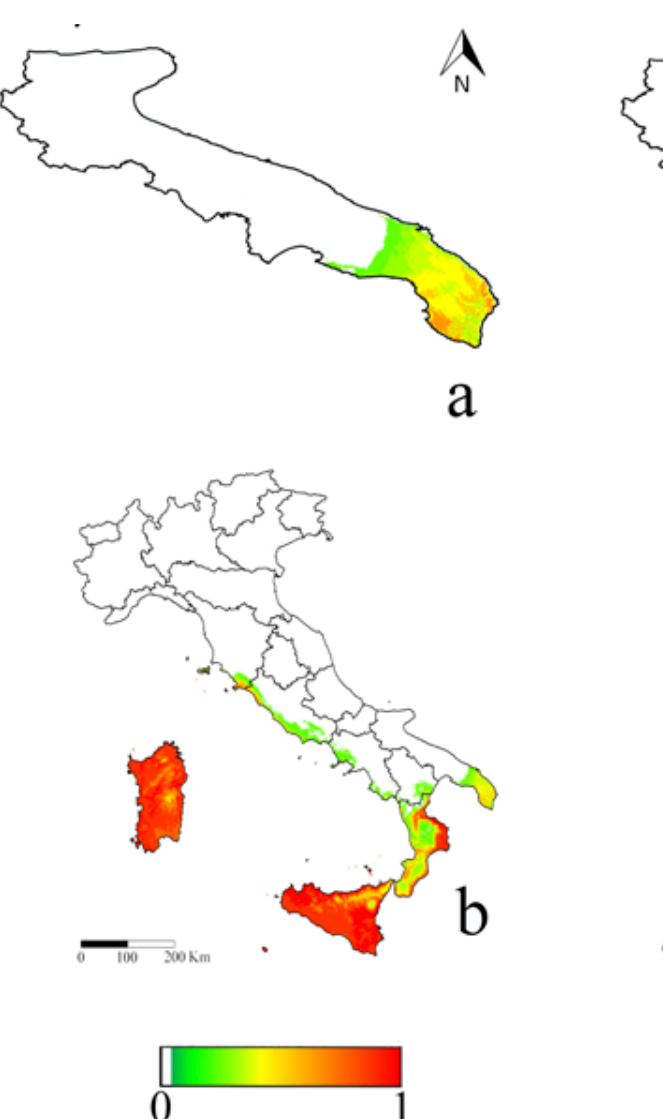
Figure 3. Binary map of Xylella fastidiosa in: (a) Apulia cali- brated with Apulia records only; and (b) Italy calibrated with presence records from